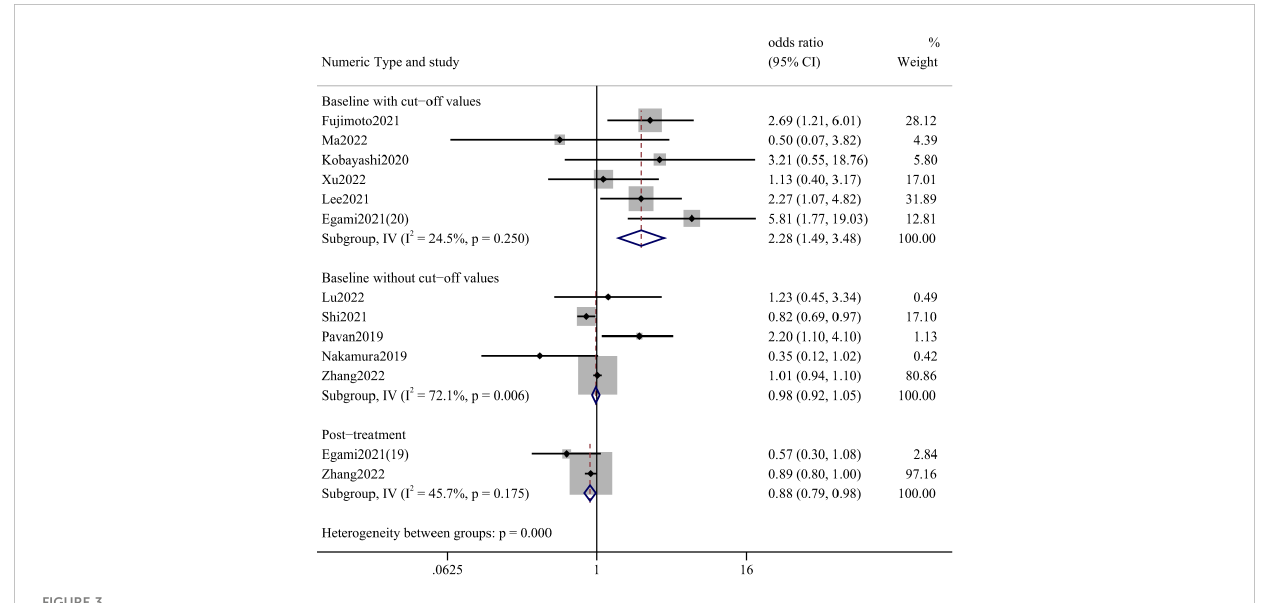
FIGURE 3 Forest plot of correlation between NLR and incidence of irAEs.